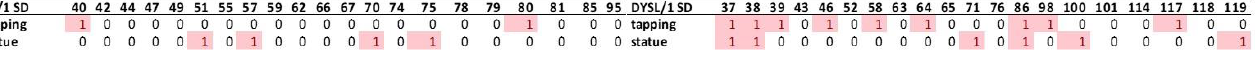
Figure 10. Deviating individual performance/cerebellar/subtest level. NT: neurotypical normal reading children, DYSL: children with dyslexia (numbers in the head row depict the individual sub- ject).